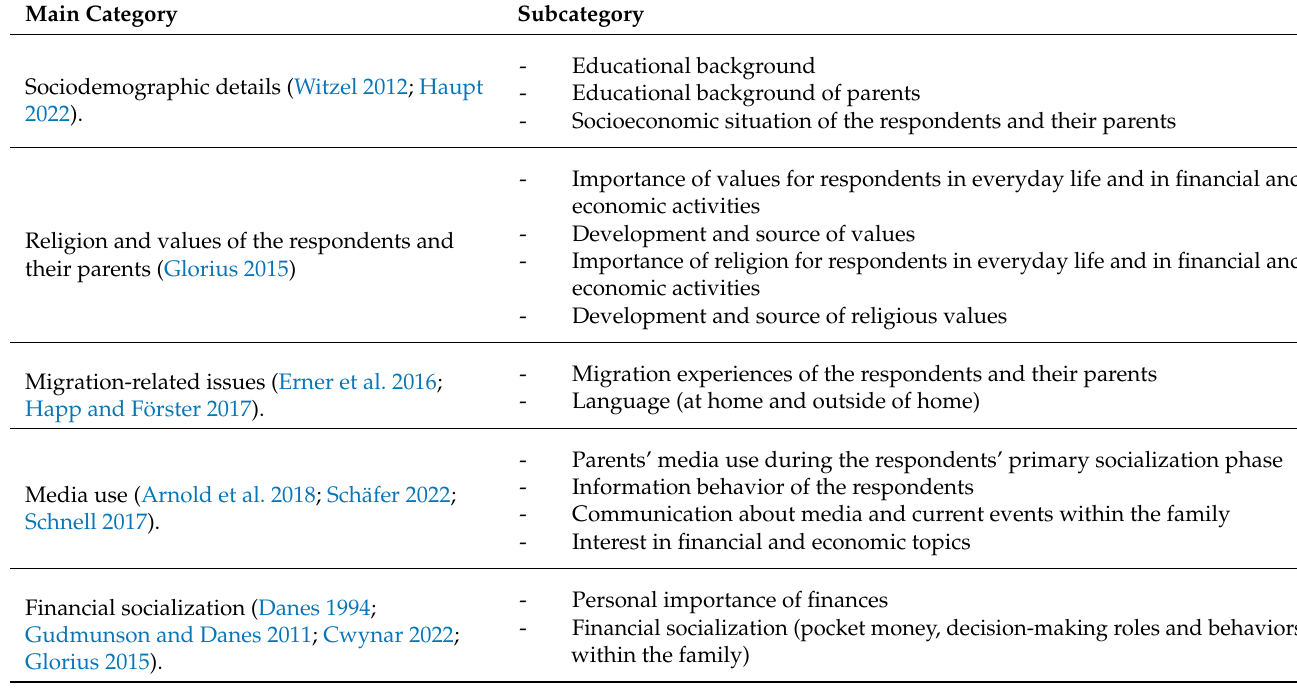
Table A1. Description of the question areas.